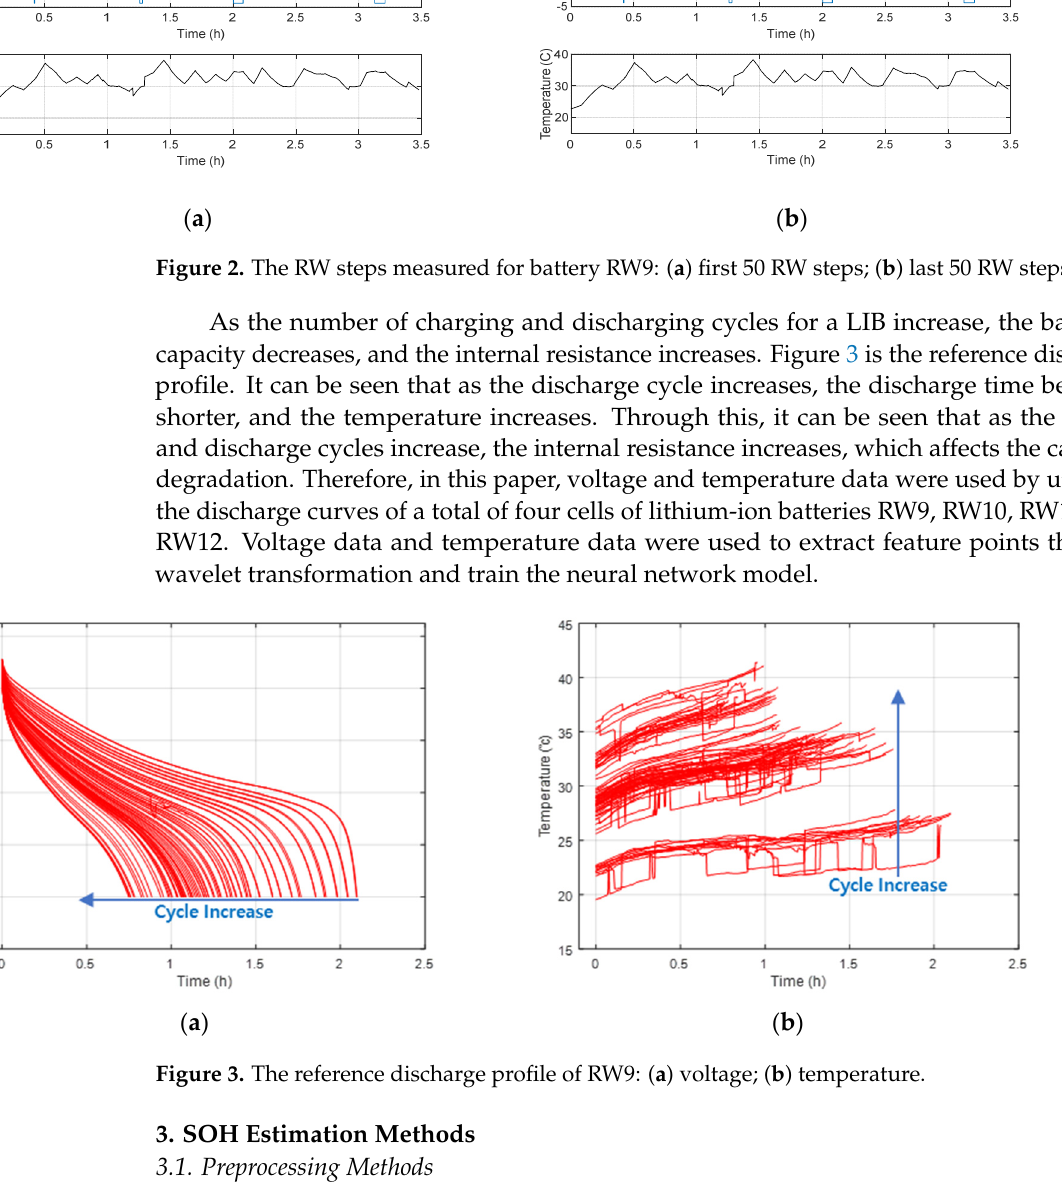
Figure 1. The whole process of data cycles.